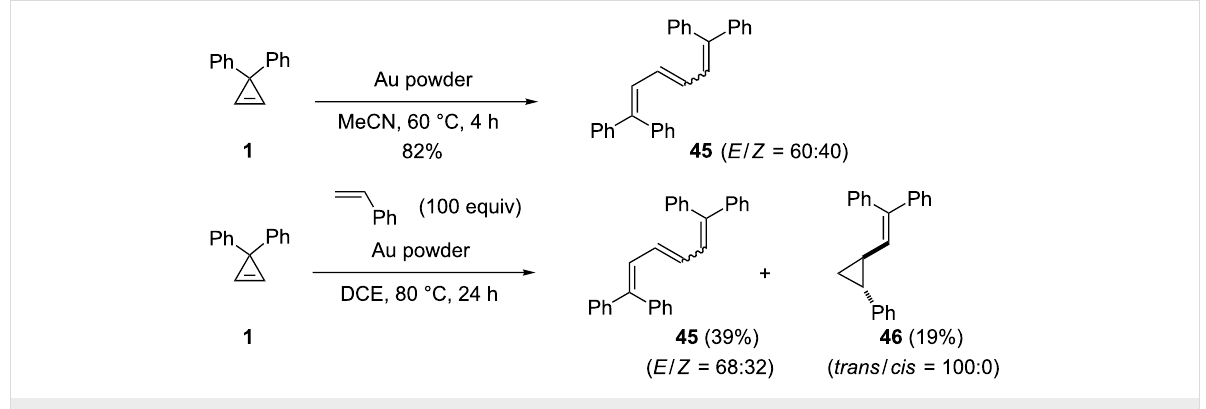
Scheme 21: Representative reactions of carbene precursors on gold metal.